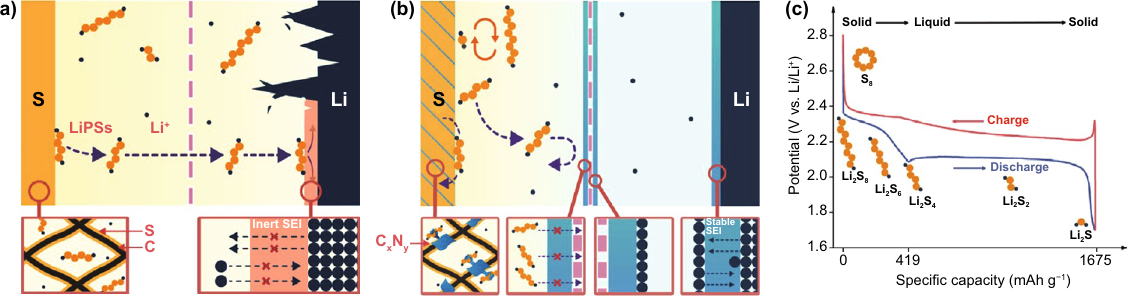
Fig. 1 Schematic illustration of a the challenging issues in common Li–S batteries and b the improved performance for modified Li–S batteries with the introduced C x N y additive in different components. c Typical discharge/charge voltage profiles of Li–S